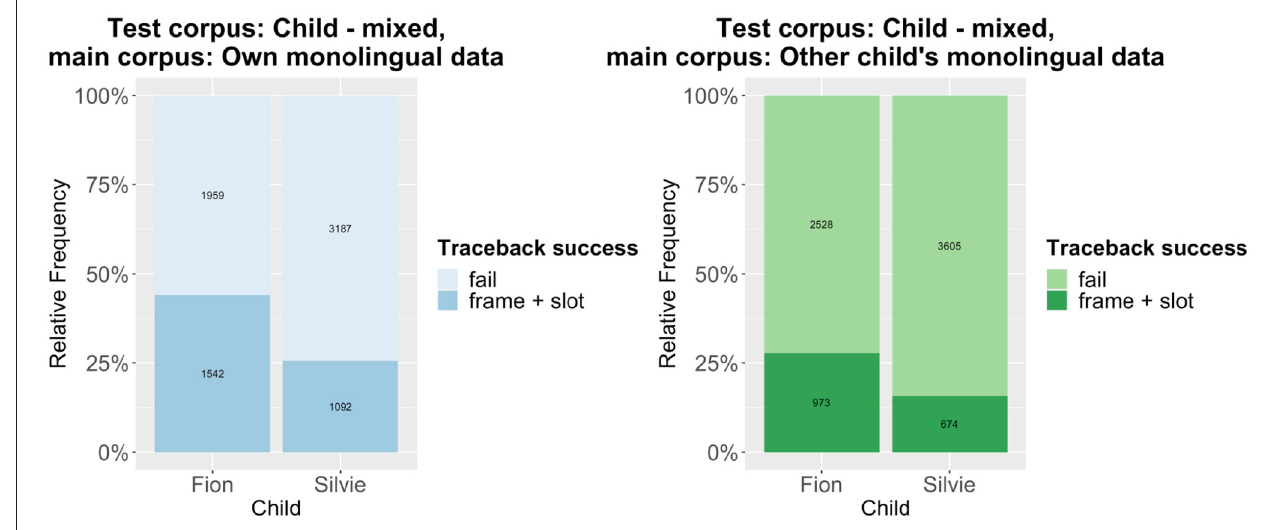
FIGURE 1 | Traceback results: Code-mixed data to monolingual data.